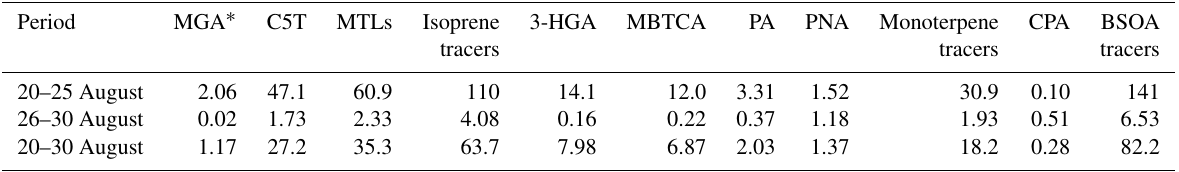
Table 2. Daytime buildups (differences between daytime and nighttime levels) of SOA tracers on days with (20–25 August) and without (26–30 August) input of anthropogenic oxidants in forest aerosols, Wakayama, central Japan. Period MGA ∗ C5T MTLs Isoprene 3-HGA MBTCA PA PNA Monoterpene CPA BSOA tracers tracers tracers